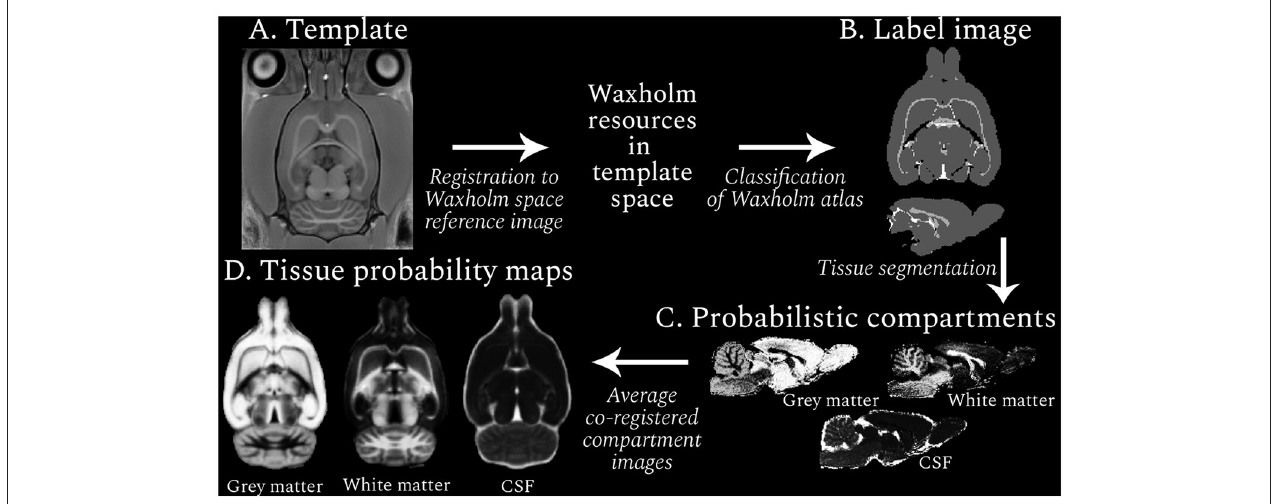
FIGURE 1 | Resource generation workflow (clockwise from top left). An example RESILIENT template is shown (A) , which was registered to the Waxholm space reference image to facilitate use of the associated resources. Regions in the Waxholm space atlas were designated as one of three tissue types, and the resulting label image (B) was used to generate probabilistic compartment images for each subject (C) . The co-registered compartments were averaged across subjects to produce tissue probability maps (D) . The voxel intensity in the probabilistic images represents the likelihood, from 0 (black) to 1 (white), of the presence of a given